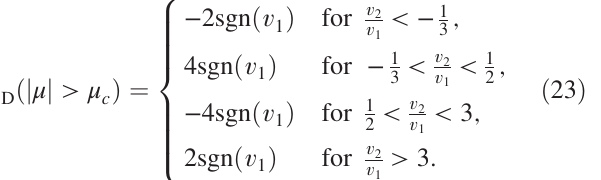
FIG. 5. Phase diagram of odd- and even-parity states spanned by U=V and v 2 =v 1 . The curves are the phase boundary for the typical values of the chemical potential. The other parameters are the same as in Fig.